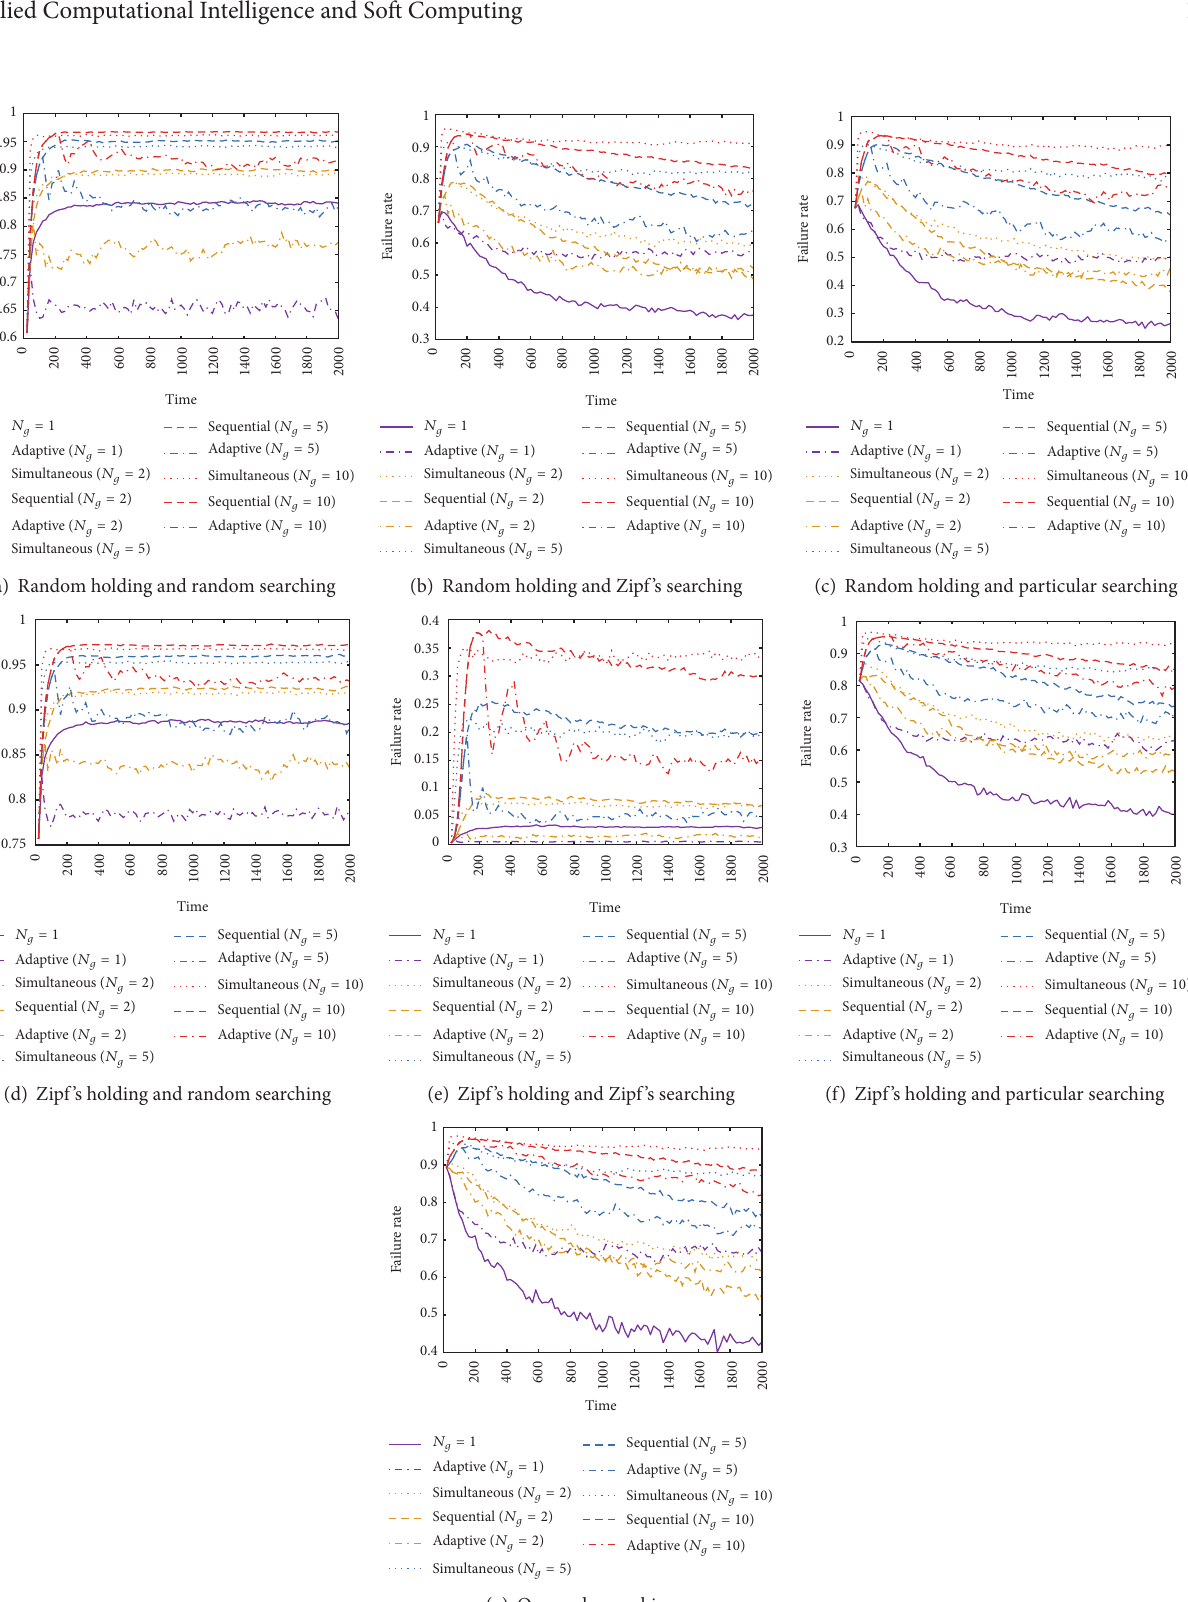
Figure 9: Simulation results of P-EP2P using the sequential and simultaneous topology evaluation methods when each node participates in the network with the probability randomly assigned in between 60% and 100% at every